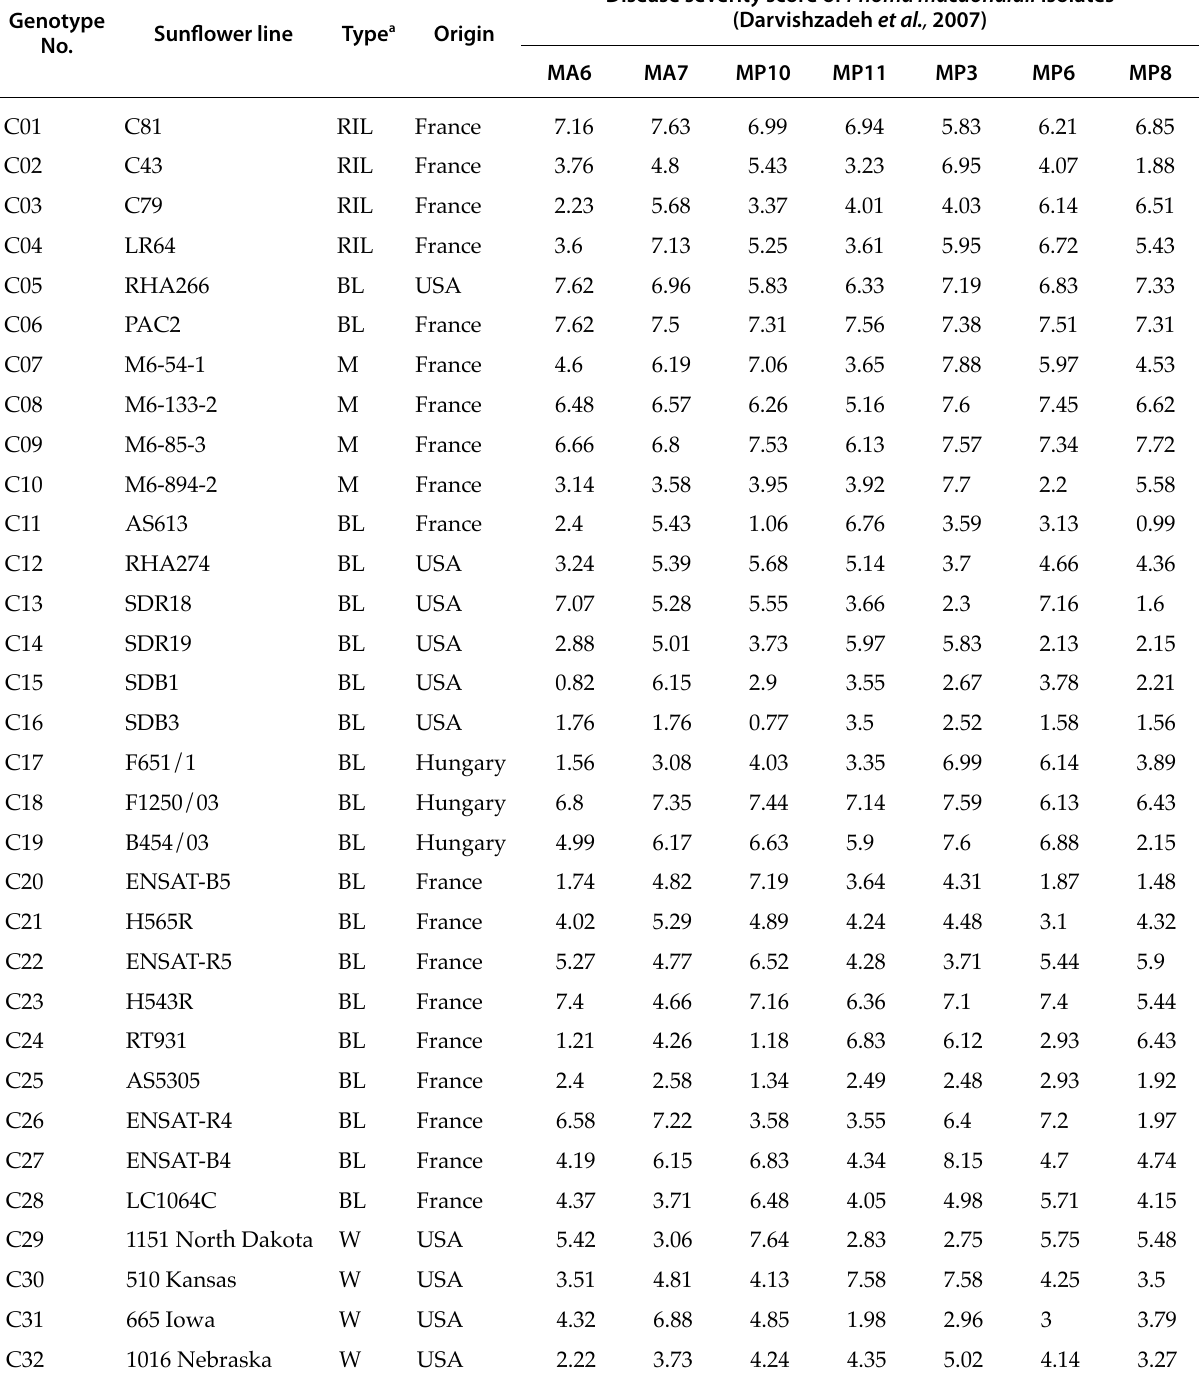
Table 1. Sunflower lines and accessions, and their country of origin, used in experiments for identification of SSR markers associated with partial resistance to Phoma macdonaldii isolates. Genotype